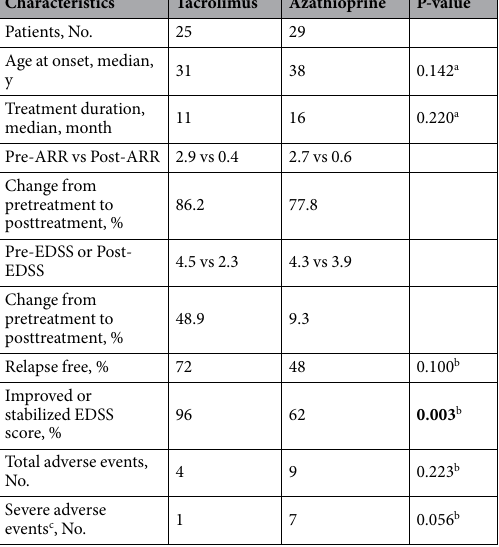
study, 18 of 25 patients (72%) were relapse-free after tacrolimus treatment, and 96% had improved or main- tained disability, although this analysis was performed in a relatively small number of patients. The efficacy was comparable with that of mycophenolate mofetil in NMOSD patients 7, 11 . In a study by So-Young et al ., mycophe- nolate provided a significant reduction in ARR (pre-ARR vs post-ARR, 2.6 vs 0.5; P < 0.001) and in EDSS score